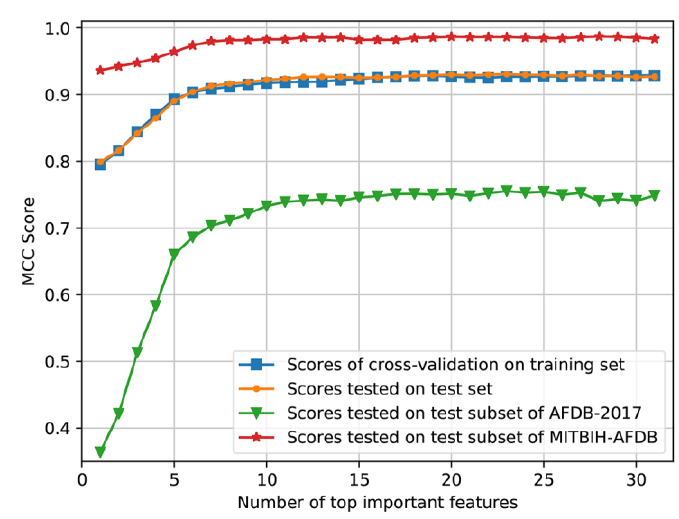
Figure 9. Illustration of the importance of the 31 features. (The top 17 features were selected to train the final classifier).